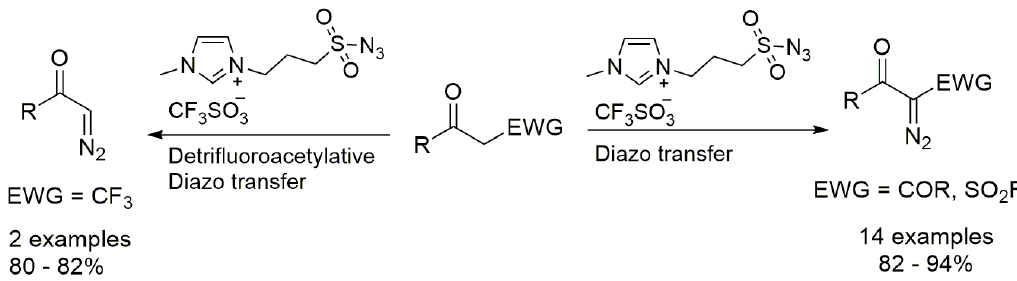
Figure 25 - Application of ionic liquid-supported sulfonyl azide in diazotransfer